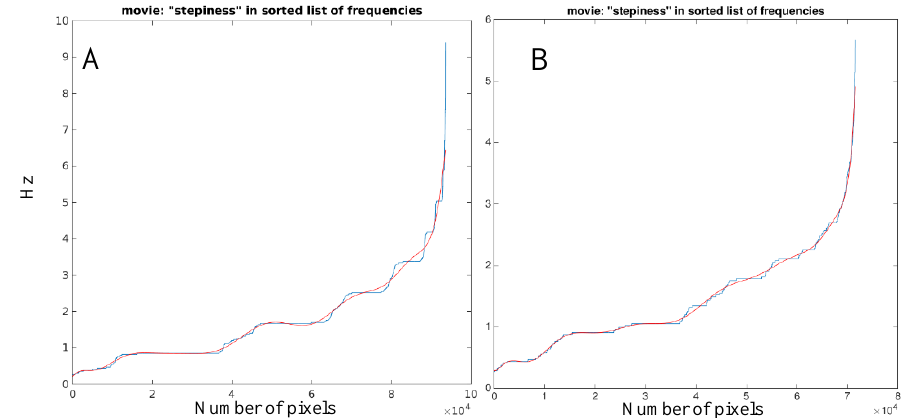
Figure 1. Panel ( A ) shows the histogram of a person walking with a well-coordinated motion pattern. Panel ( B ) shows the histogram of a man a ff ected by Parkinson’s disease walking.